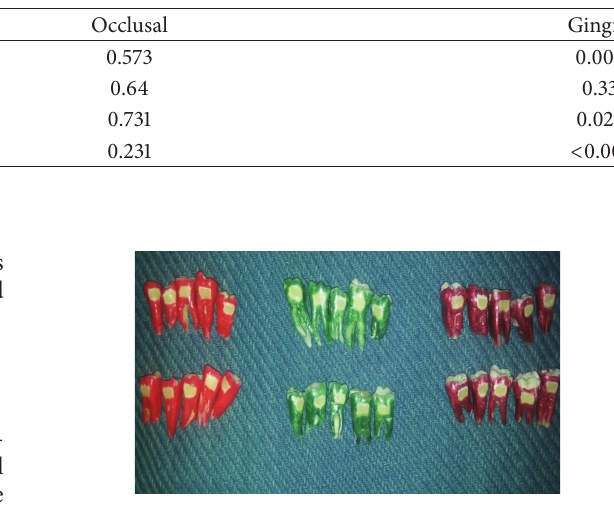
Figure 1: Three different